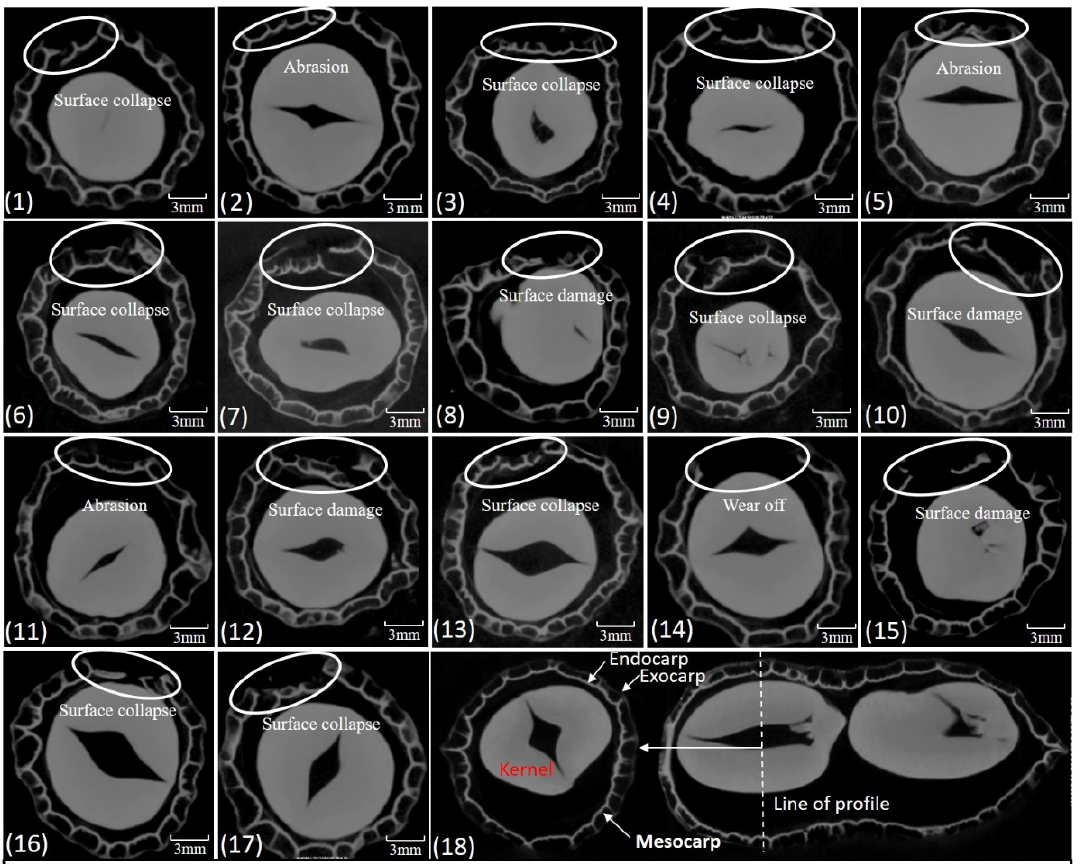
Figure 12. Micro-CT scan images of peanut cross-section. ( 1 )–( 17 ) are the scan images after the orthogonal test and ( 18 ) is the scan image before the orthogonal test.